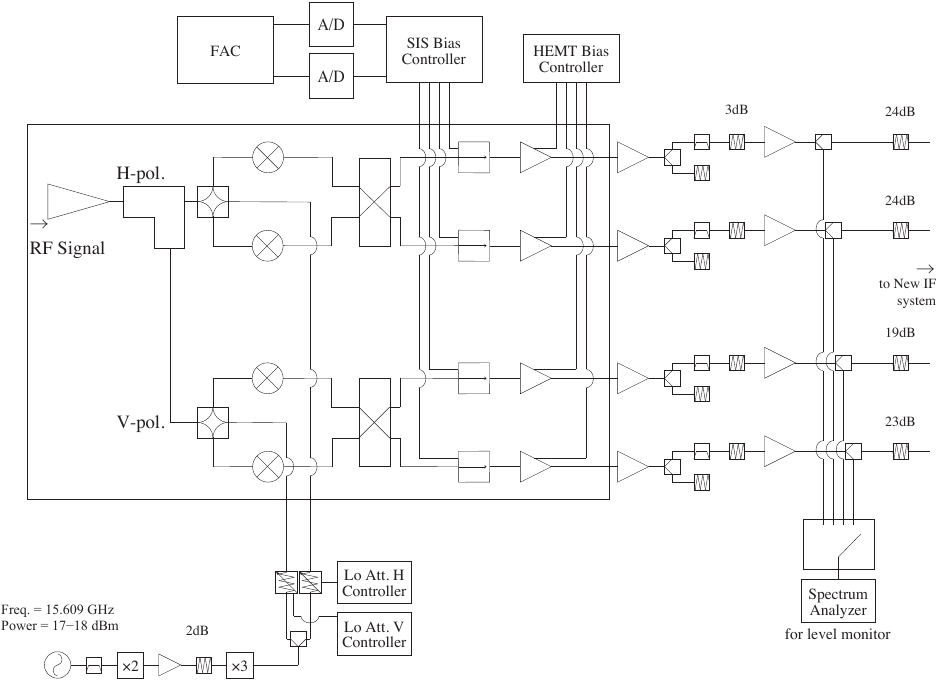
Figure 2. The block diagram of the refurbished TZ receiver.“FAC” is the FA (factory automation) con- troller used to monitor the SIS-Bias, measurement instruments, etc., while “ × 2” and “ × 3” represent frequency multipliers used for up-conversion to a higher